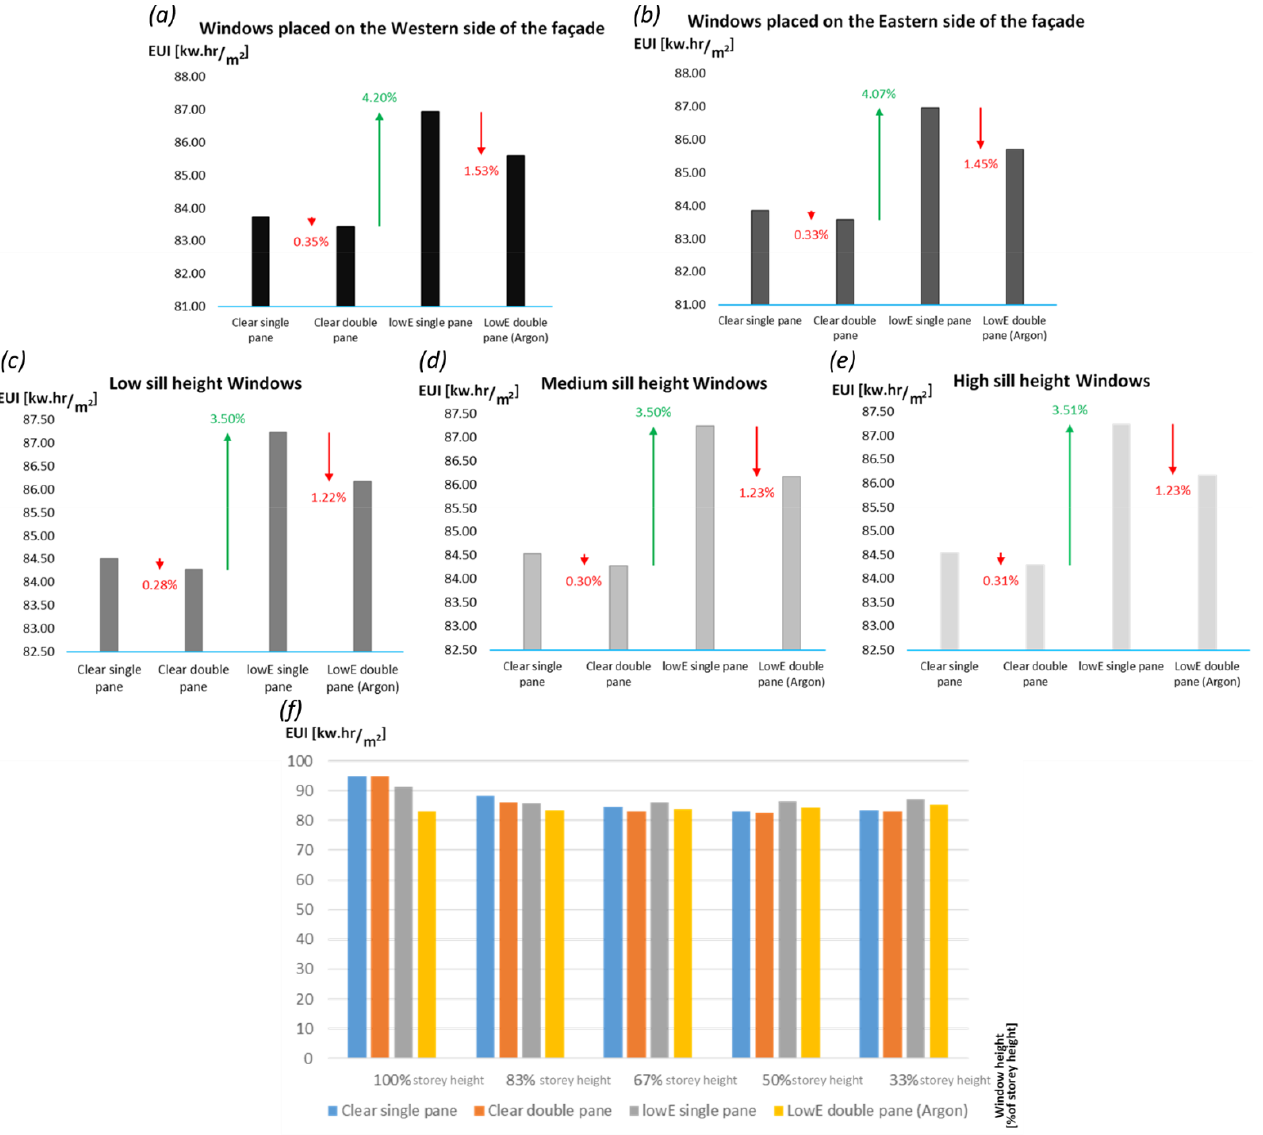
Figure 8. ( a ) EUI differences for different window positions relative to the envelope for the western- side-placed window; ( b ) EUI differences for different window positions relative to the envelope for the eastern-side-placed windows; ( c ) EUI differences for low-sill windows; ( d ) EUI differences medium-sill windows; ( e ) EUI differences for high-sill windows; and ( f ) EUI differences for different window relative height to the envelope l for the W w = L window placed at the envelope centre for different glazing properties.